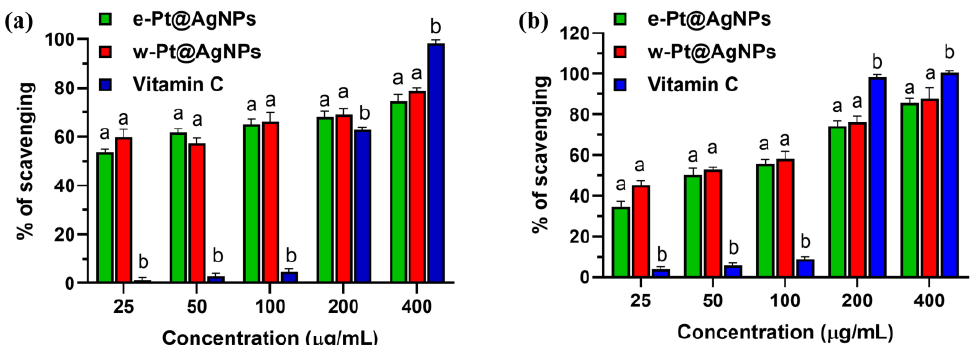
Figure 6. The inhibition of ( a ) ABTS and ( b ) DPPH radicals by w -Pt@AgNPs and e -Pt@AgNPs. Values are mean ± SD ( n = 3). Mean separation by LSD. A set of bars (the same concentration) with different alphabets is significant. Table 2. FRAP value and IC 50 from the w -Pt@AgNPs, e -Pt@AgNPs, and Standard Drug.